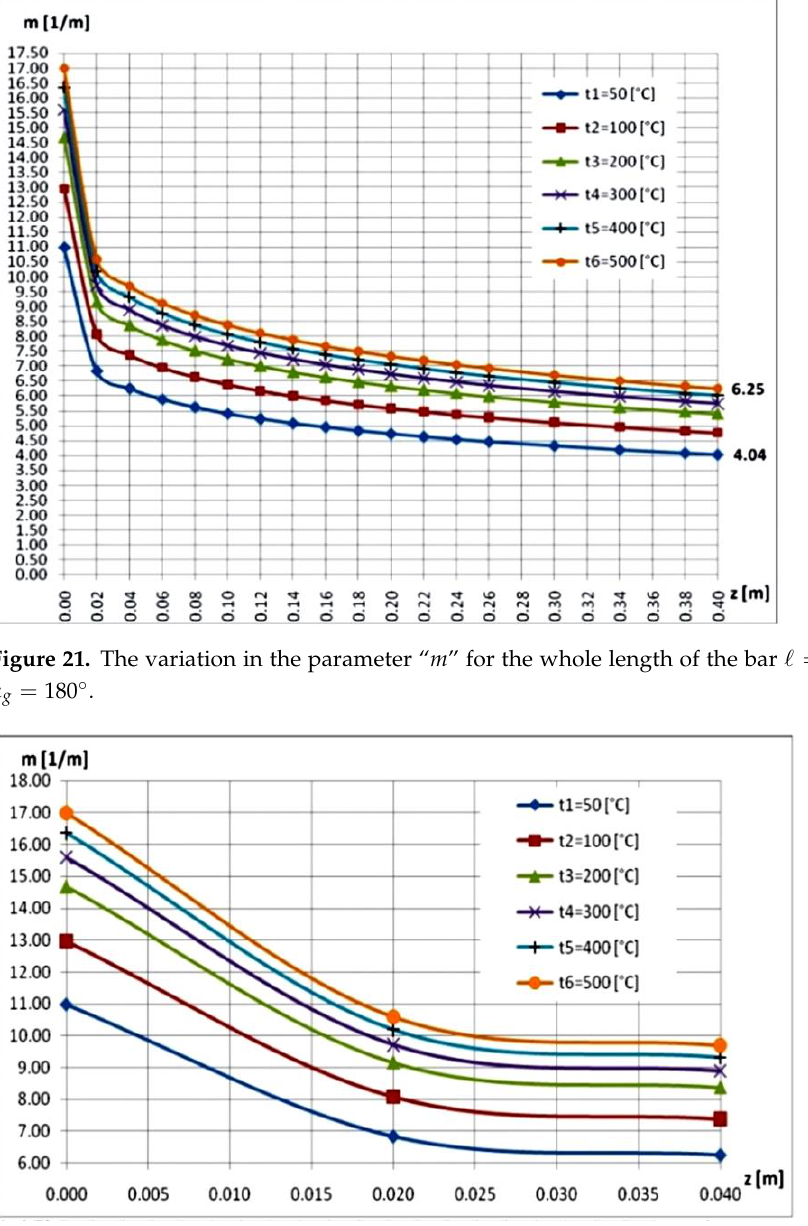
Figure 22. The variation in the parameter “ m ” along the first significant interval of the bar ( (cid:96) (cid:48) I = z = [ 0.000 − 0.040 ] m ) , for α g = 180 ◦